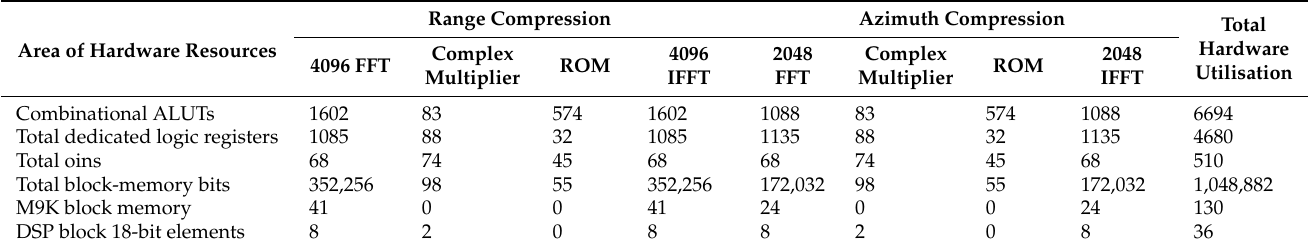
Table 4. Total resources utilisation of the proposed SAR processor.